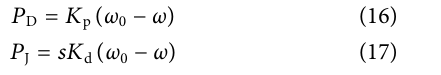
Frontiers in Energy Research |